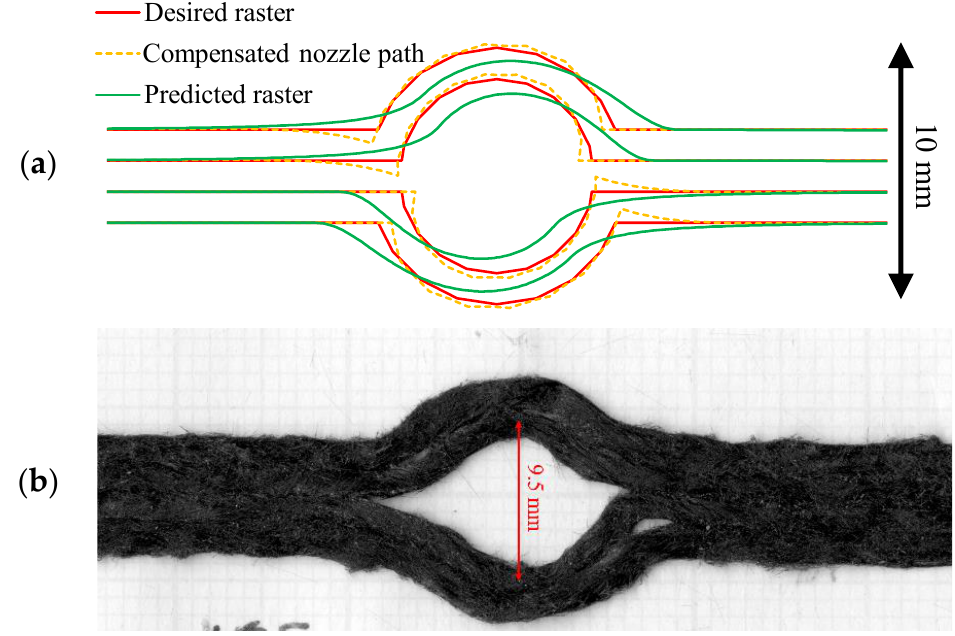
Figure 12. 10 mm diameter curvilinear open hole part (D10): ( a ) coordinates of desired raster (red), compensated nozzle path (yellow dotted) and predicted raster (green); ( b ) deposited raster.